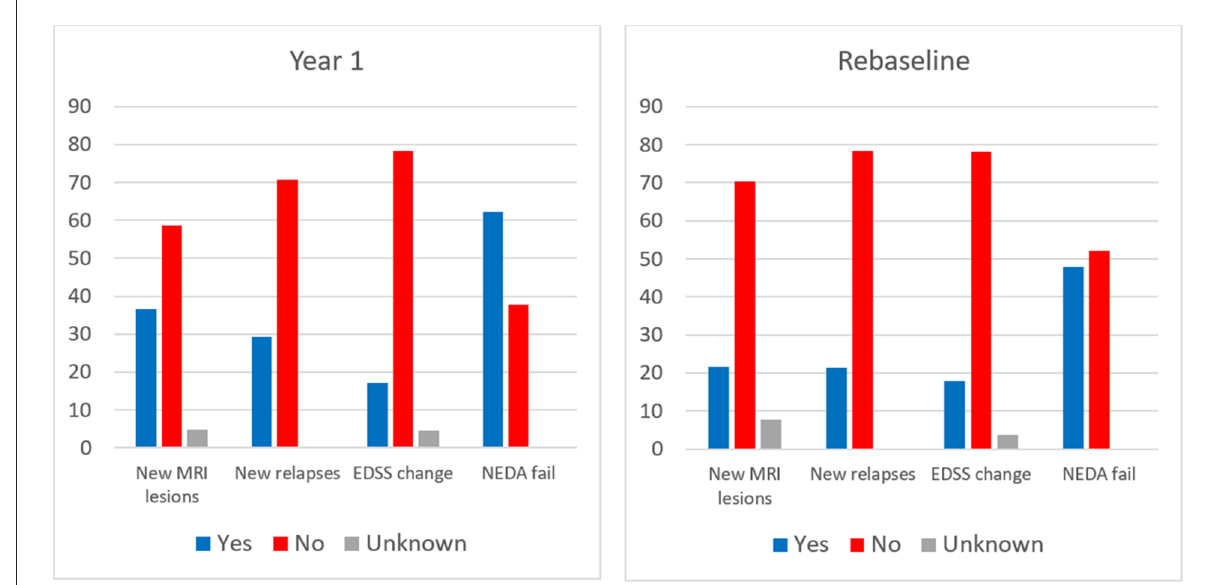
FIGURE6 Individual components of NEDA in all pwMS in year one and at rebaseline. EDSS expanded disability status scale. NEDA no evidence of disease activity. MRI magnetic resonance